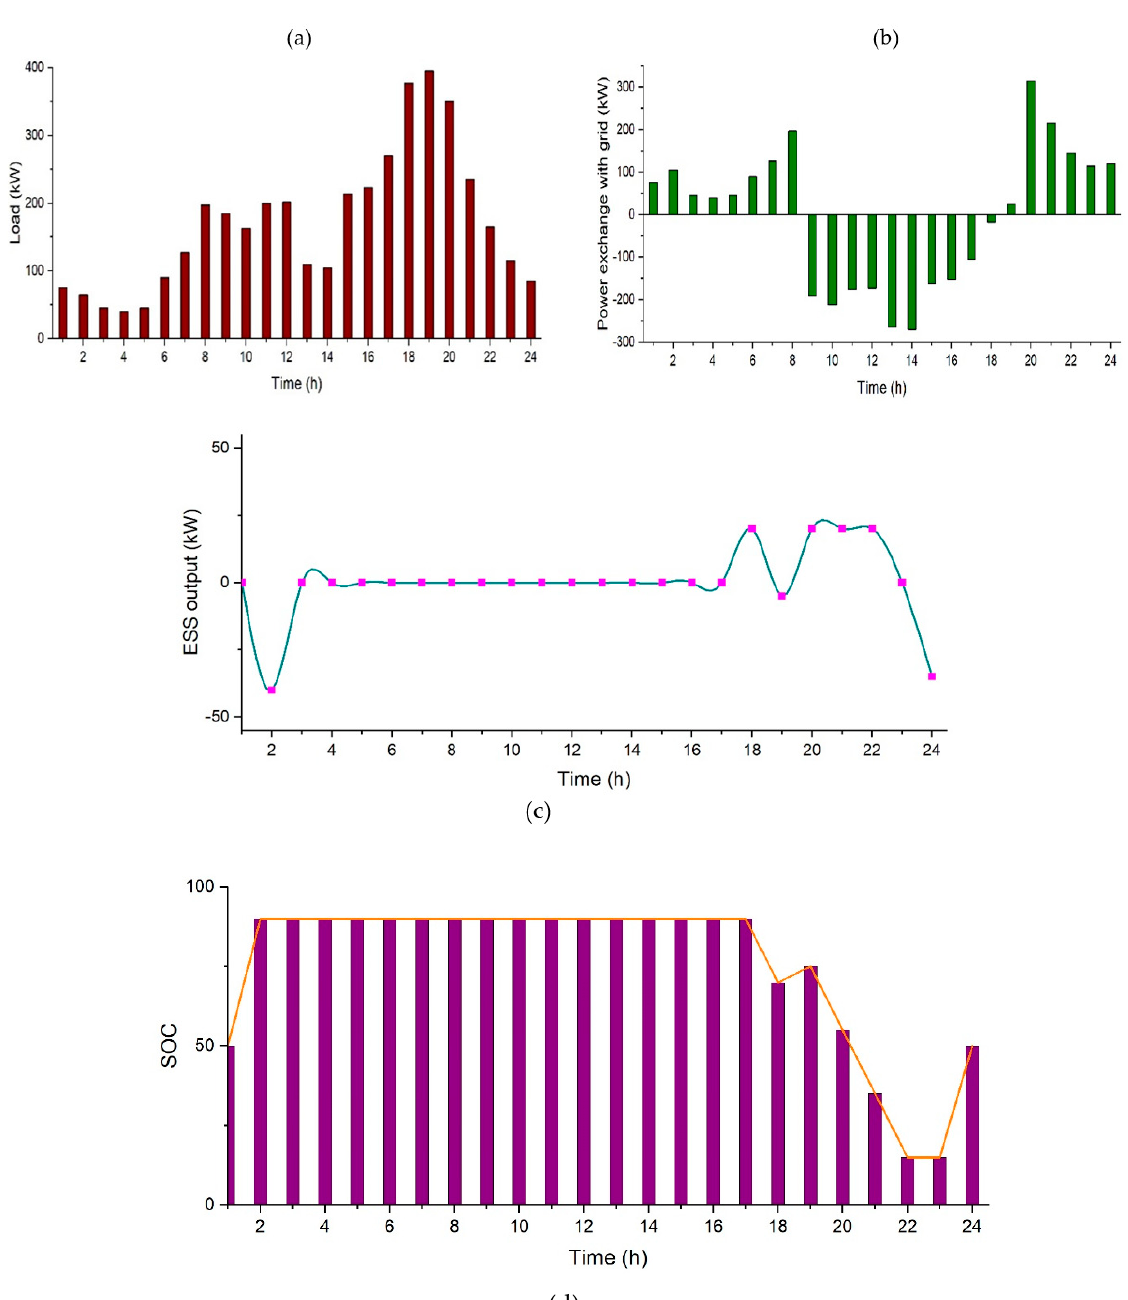
Figure 9. Case 2, ( a ) College prosumer load profile, ( b ) Power exchange with the grid, ( c ) Power output of ESS , and ( d ) State of charge of the battery.